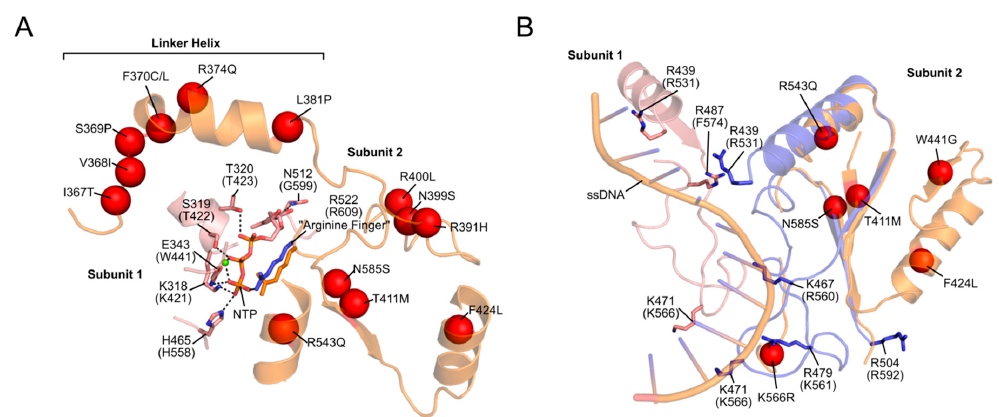
Figure 5. Disease-causing mutations in the NTP-binding and ssDNA-binding regions of TWINKLE. Disease-causing mutations in TWINKLE are often associated with defective ATPase and ssDNA-binding activities, leading to impaired helicase activity and subsequent stalling at the replication fork. The TWINKLE CTD (orange) was aligned to the T7 gp4 CTD (grey/blue; PDB ID: 6N9V). In cases where the T7 residues are shown, the equivalent residue number in TWINKLE is given in parentheses.